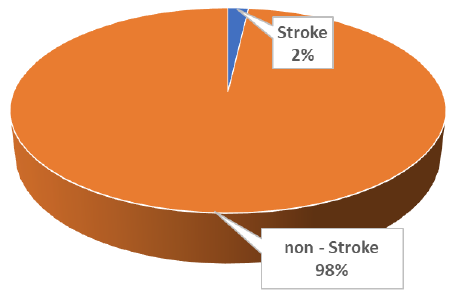
Figure 1. Rates of classes in the binary